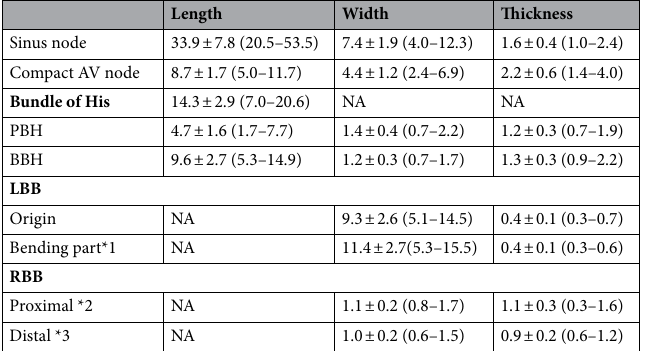
These results showed that each SN inclination significantly correlated with each cardiac inclination in the sagittal (dorso-ventral), frontal (vertico-transverse), and horizontal (right- and leftward) rotations (Fig. 2d–f). The reference line connecting the end of the compact AV node and the branching point of the RBB, which is a relatively linear part of the AVCA, served as the reference axis for the AVCA (column 3 in Fig. 2 and Table 2). Since it was difficult to define the measurement point for RBB and LBB, which makes a large curve along the way, only the proximal part—which can be measured as a relatively direct part—was measured in the horizontal plane. The average inclinations of the AV conduction components were: angle (βsgt) of the bundle of His to the horizontal line was 34.5 ± 12.9° cranially in the right lateral view (Fig. 2a3); angle (βfrt) of the bundle of His to the sagittal line was 147.2 ± 17.6° to the left in the frontal view (Fig. 2b3), and angle (βhzt) of the bundle of His to the horizontal line was 30.2 ± 12.4° in the horizontal view (Fig. 2c3). The RBB angle (γ) to the sagittal line was 41.5 ± 15.7° to the left in the superior (head) view (Fig. 2c3), and the LBB branching angle (δ) of the center LBB from the bundle of His to the sagittal line was 120.2 ± 14.6° to the left in the superior (head) view (C). The relationships between the sagittal, frontal, and horizontal cardiac rotations (X sgt , X frt , and X hzt ) and those of the corresponding proximal AVCA rotations (β sgt , β frt , and β hzt ) were as follows: